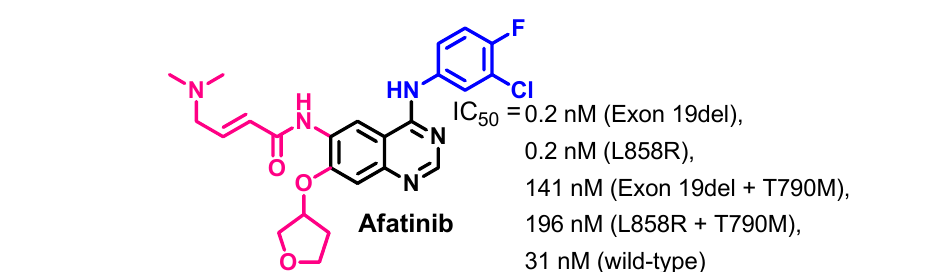
Scheme 1. Synthesis route of afatinib.